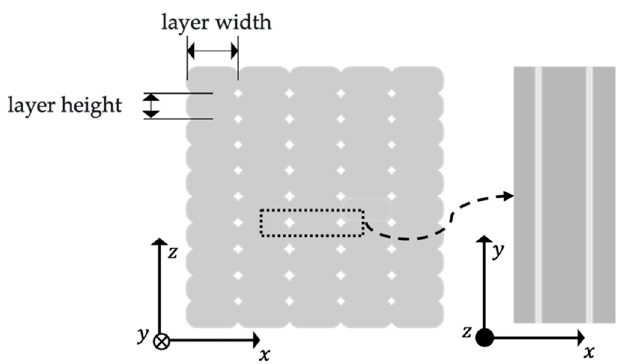
Figure 2. Schematical view of connected channel pores after sintering. The z -direction represents the stacking direction, while the x-y plane is the printing plane.